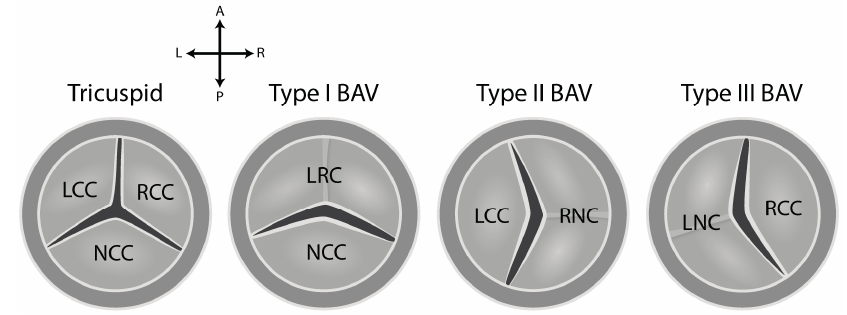
Figure 7. Anatomy of the bicuspid valve and potential pathways for its development. The bicuspid valve is classified as Type I: fusion of the right coronary cusp (RCC) and left coronary cusp (LCC) to create a fused left-right cusp (LRC). A Type I BAV results from persistent fusion of the left and right leaflets normally be formed by the superior and inferior septal cushions. Type II: fusion of the RCC and non-coronary cusp (NCC) to create a fused right-non-coronary cusp (RNC). Type III: fusion between the LCC and NCC to create a fused left-non-coronary cusp (LNC). Both Type II and Type III BAVs result from fusion of the posterior aortic interacted disc with either the inferior (Type II) or superior (Type III) septal cushion. These differences in anatomy imply differences in etiologic mechanisms